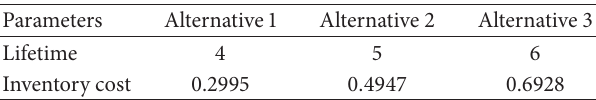
Table3:Lifetimeandinventoryholdingcostofbloodplateletdriven from